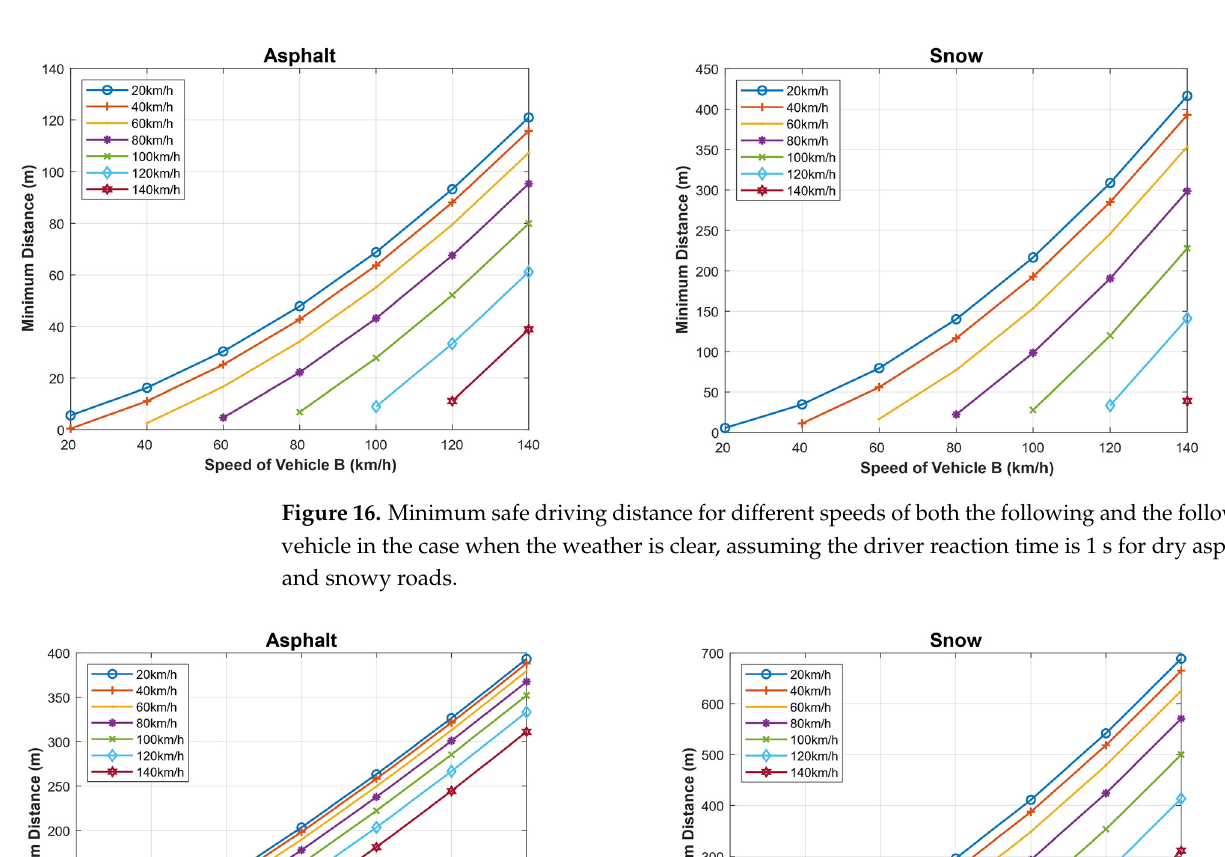
Figure 15. In foggy weather: maximum speed of the following vehicle for different speeds of the followed vehicle for different initial distances between the two vehicles when the driver reaction ( 𝑇 (cid:3045)(cid:3002) = 8 s ) .